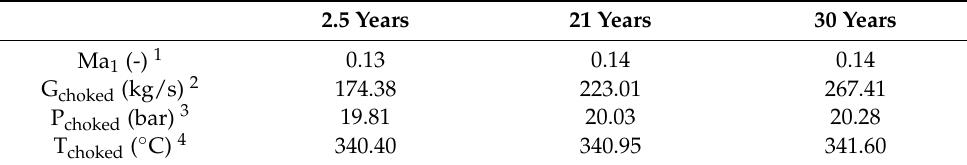
Table 4. Mass flow rate calculation results at 2.5, 21 and 30